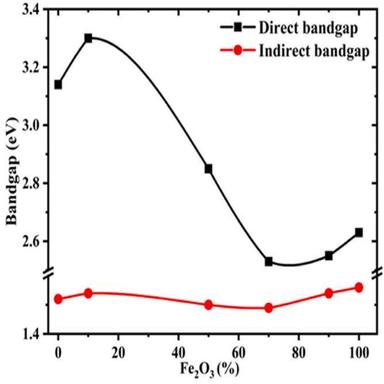
Effect of Fe2O3 (%) contents on the direct and indirect bandgap of (In2O3)/(Fe2O3) nanocomposite.